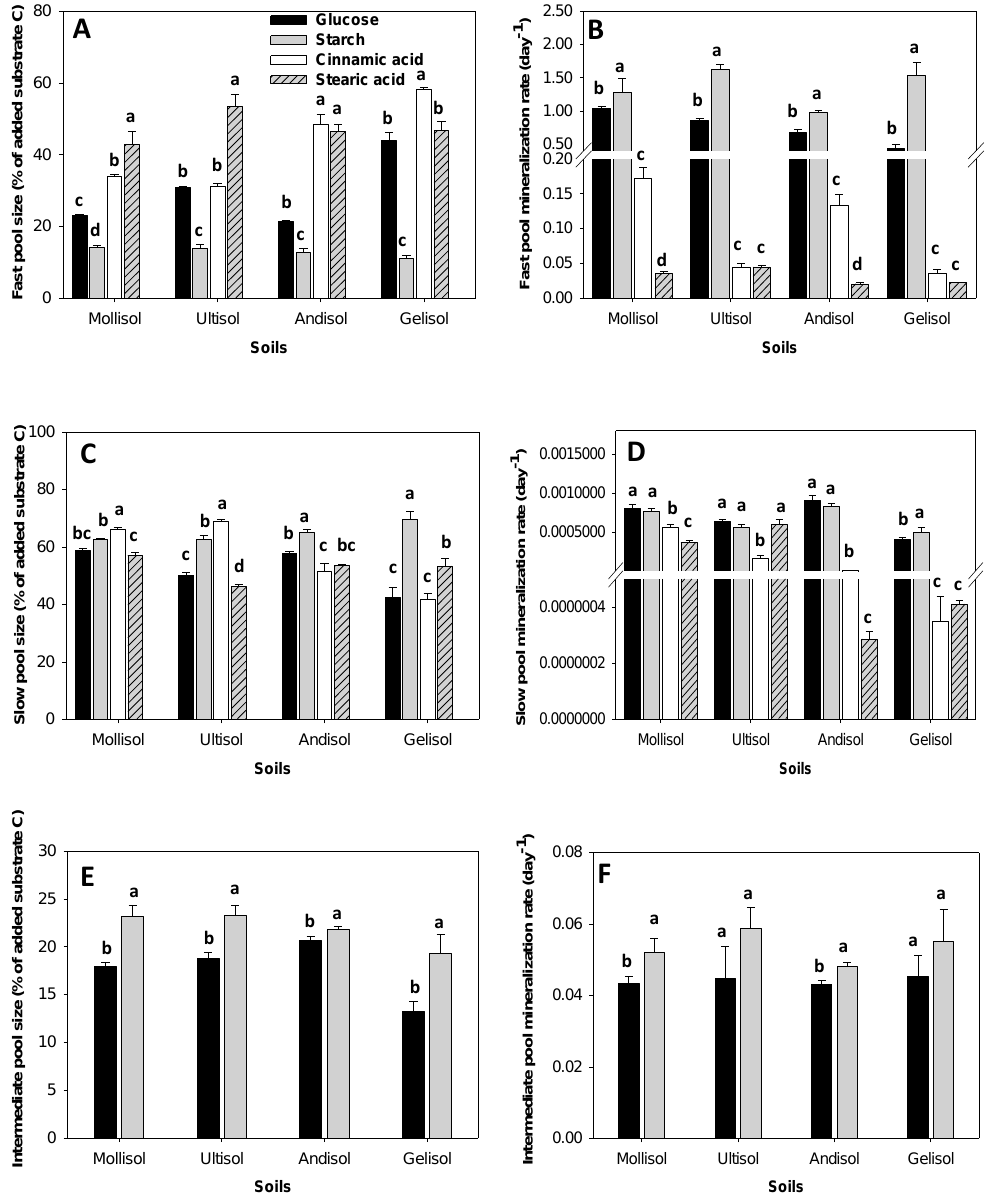
Figure 5. Effect of substrate types on substrate C mineralization parameters: size of fast pool (a) , mineralization rate of fast pool (b) , size of slow pool (c) , mineralization rate of slow pool (d) , size of intermediate pool (e) and mineralization rate of intermediate pool (f) . Pool sizes of 14 C glucose and 14 C starch respiration (fast, intermediate and slow pools) and their associated mineralization rates ( k 1 , k 2 and k 3 ) were best modeled by a triple pool model, and pool sizes of 14 C cinnamic acid and 14 C stearic acid respiration (fast and slow pools) and their associated mineralization rates ( k 1 and k 2 ) were best modeled by a double pool model. Lower-case letters on top of bars represent statistical significance at P < 0 .